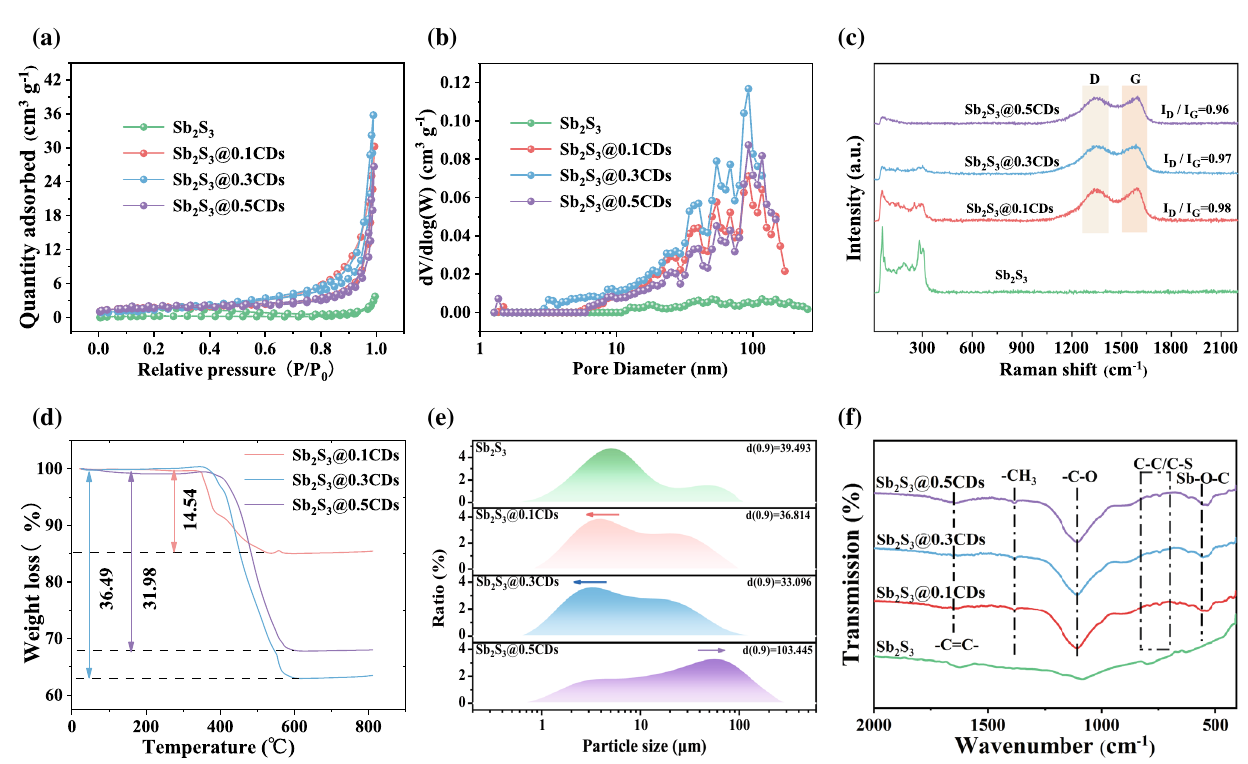
Fig. 3 a Nitrogen adsorption–desorption isothermal curves. b The pore size distribution curves. c Raman spectra. d TGA curves. e Size distri- butions. f FT-IR spectra from 400 to 2000 cm